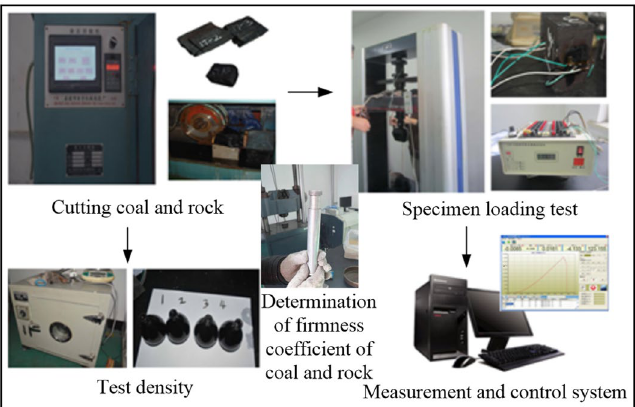
Figure 17. Performance test of coal and rock.